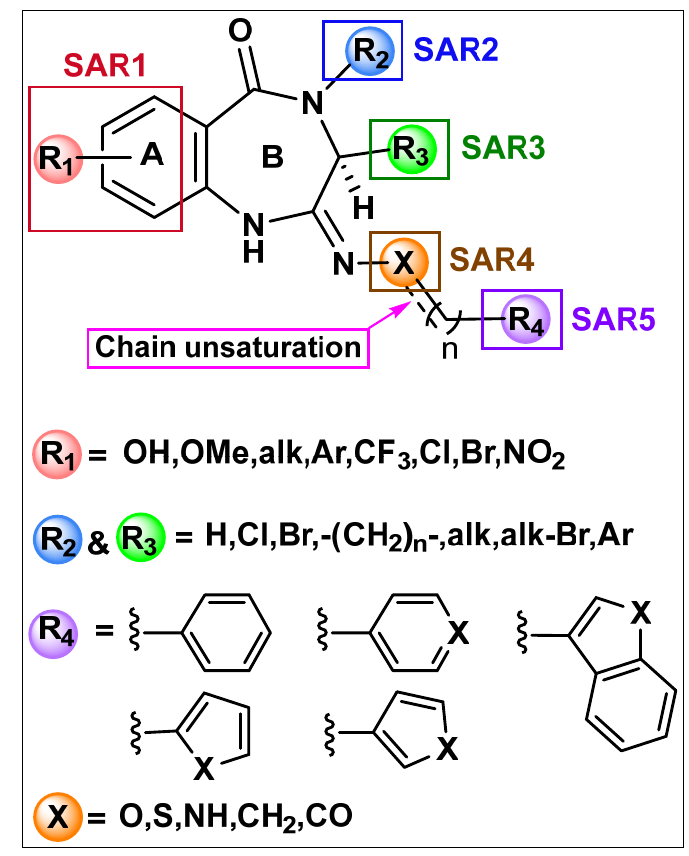
Figure 1. Structures of the proposed analogs.